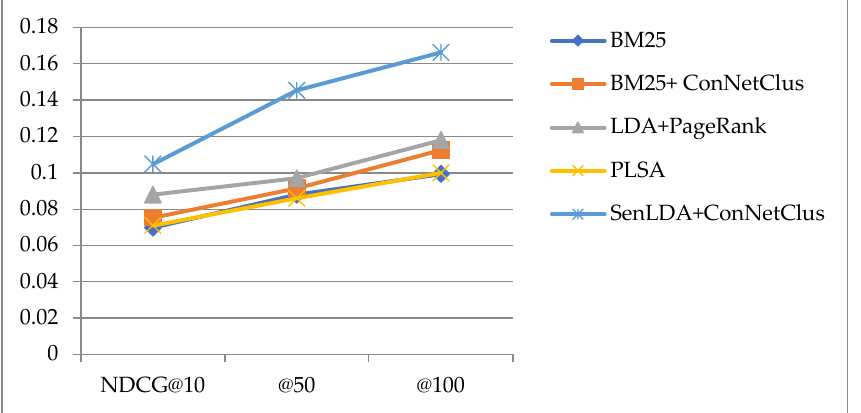
Figure 7. Experimental results of average scores in NDCG.